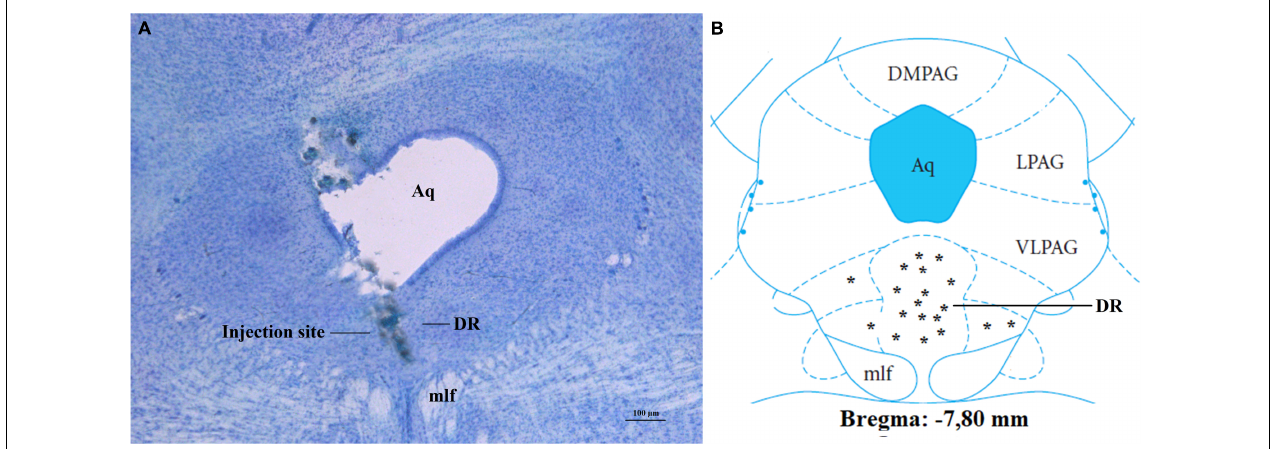
FIGURE 1 | Confirmation of injection sites into DR of fasted rats. (A) Photomicrograph of a stained section, showing injection site into the DR. (B) Injection sites at the bregma level:7, 80 mm; other injection sites were located at-7.32 to-8.04 mm to bregma. Aq, aqueduct; DR, dorsal raphe nucleus; DMPAG, dorsomedial periaqueductal gray; LPAG, lateral periaqueductal gray; VLPAG, ventrolateral periaqueductal gray; mlf, medial longitudinal fasciculus. Scale bar = 100 µ m. *, location of each injection site.